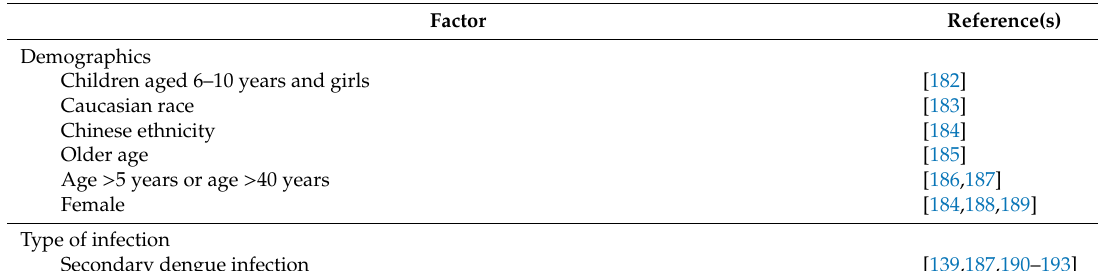
Table 4. Factors associated with severity of